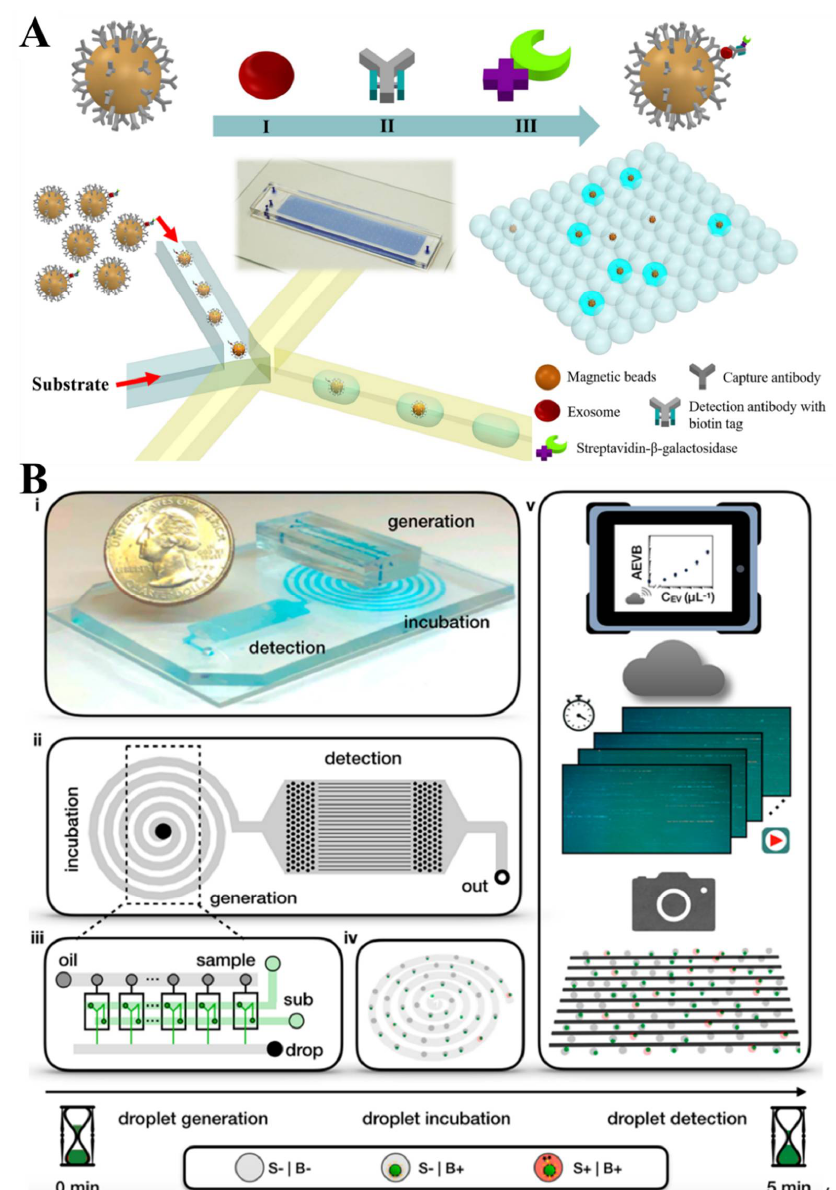
Figure 4. ( A ) The droplet-based single-exosome-counting enzyme-linked immunoassay (droplet digital ExoELISA) approach for the single EV counting. Reprinted with permission from [59]. Copyright 2018, American Chemical Society. ( B ) Single EV detection on a droplet-based extracellular